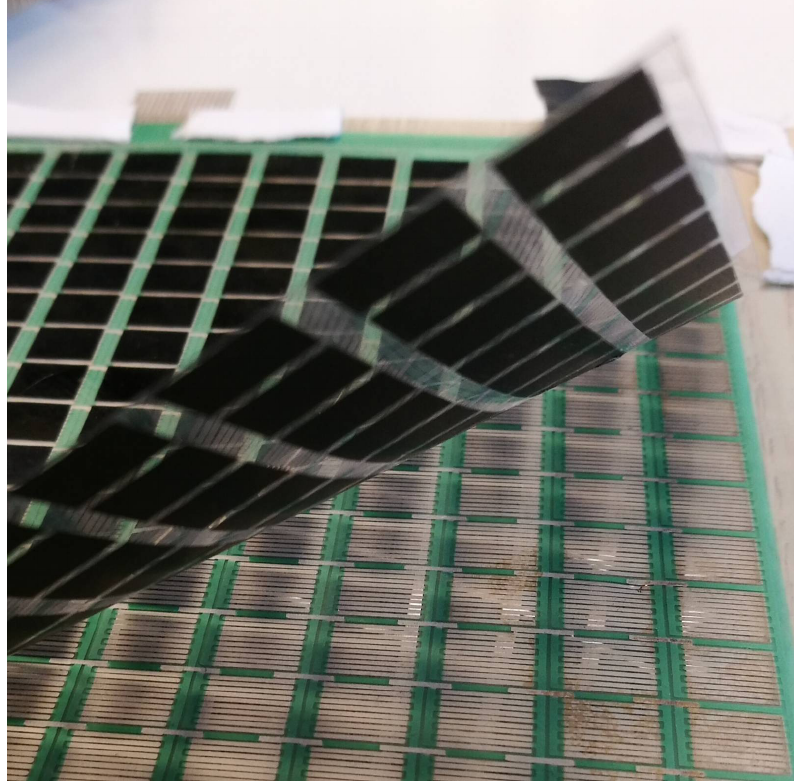
Figure 1. The robotic skin: the upper FSR sensors arranged in a rectangular pattern placed on a plastic foil, and the lower conductive layer of comb electrodes printed on plastic